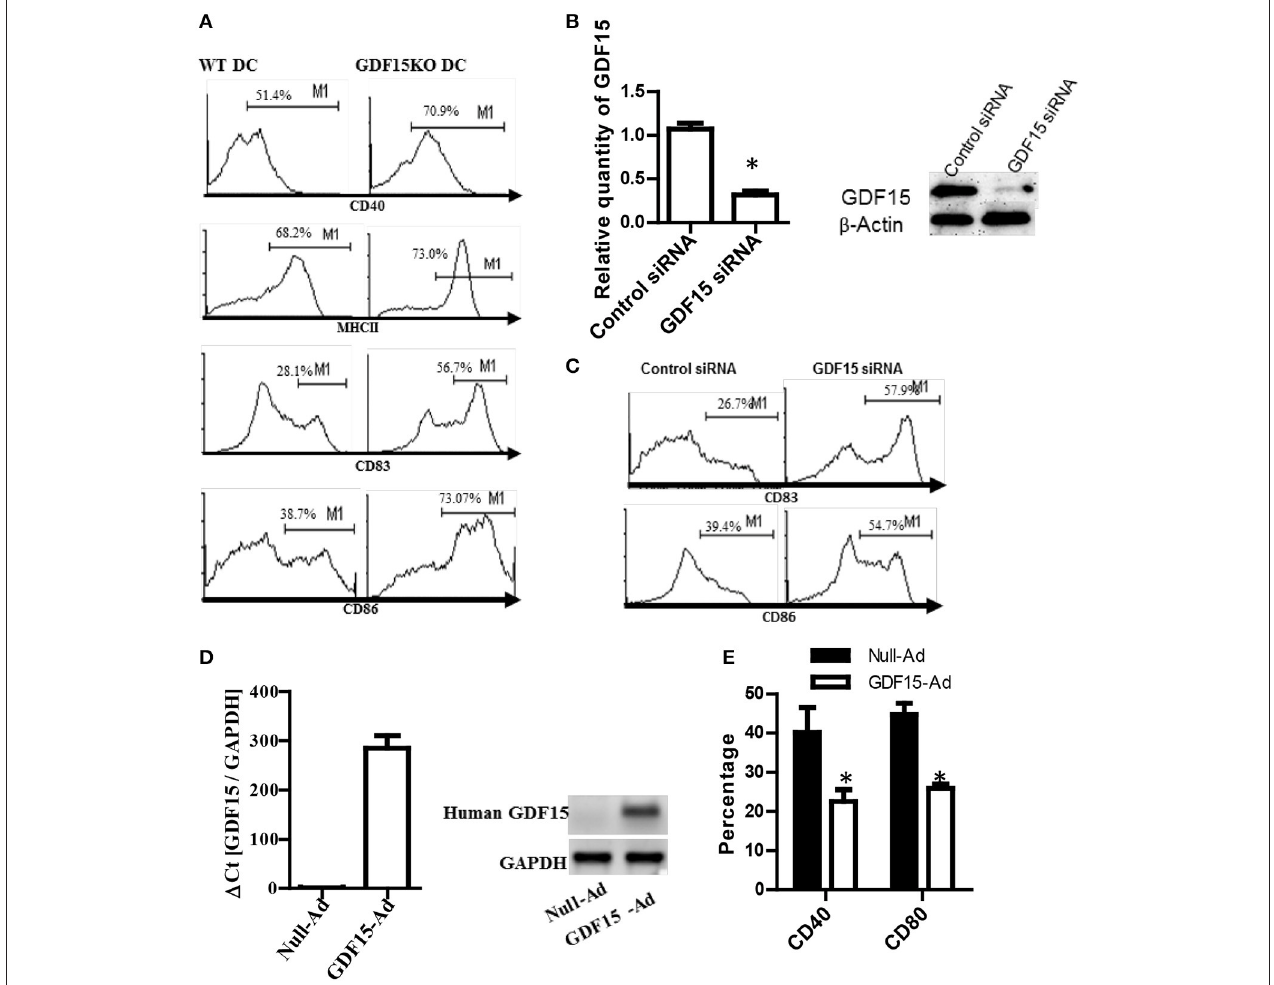
FIGURE 2 | Knockout of GDF15 promoted DC maturation. (A) GDF15 KO DCs promoted DC maturation. BM-derived DCs were cultured from GDF15 KO and WT mice. On day 6, DCs were stimulated with 50ng/ml LPS for 3h. DC maturation was detected by measuring the expression of MHCII, CD40, CD83, and CD86 using flow cytometry. Images were representatives of n = 4. (B) GDF15 silenced GDF15 expression in DCs. Day 5 DCs cultured from WT mice were transfected with GDF15 siRNA for 24h. GDF15 expression was determined by qRT-PCR (left) and Western blotting (right). n = 3, the student T -test was conducted for statistical analysis of qRT-PCR results. (C) GDF15 siRNA increased the expression of CD83 and CD86 in DCs. DCs were transfected with GDF15 siRNA. 24h after transfection, CD83 and CD86 expression was detected by flow cytometry. Data were representatives of n = 3. (D) GDF15-Ad increased GDF15 expression in DCs. Day 4 DCs were infected with 100MOI of adenovirus expressing human GDF15 qRT-PCR (left, n = 3) and Western blotting (right). Data were representatives of n = 3. (E) GDF15-Ad decreased CD40 expression in DCs measured by flow cytometry. n = 3, the student T -test was conducted for statistical analysis. * P < 0.05.